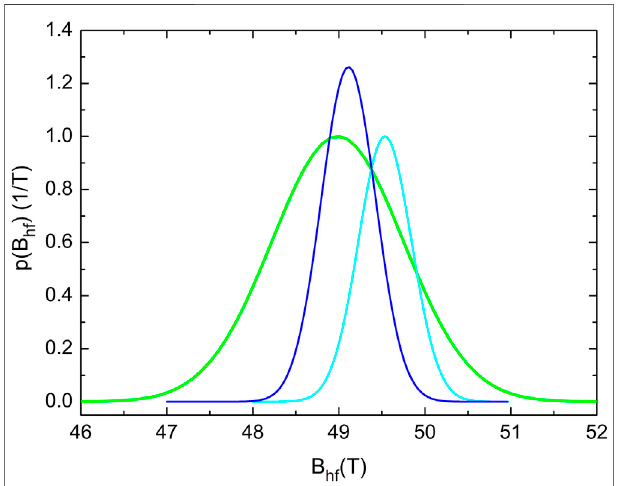
FIGURE 5 | HFDs derived from the 57 Fe Mössbauer spectra of the referenceBiFeO 3 (darkandlightbluelines)andtheas-preparedBiFeO 3 (green